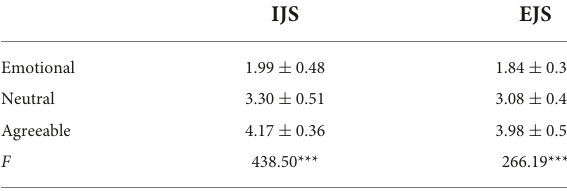
TABLE 4 Results of ANOVA and post hoc comparisons on job